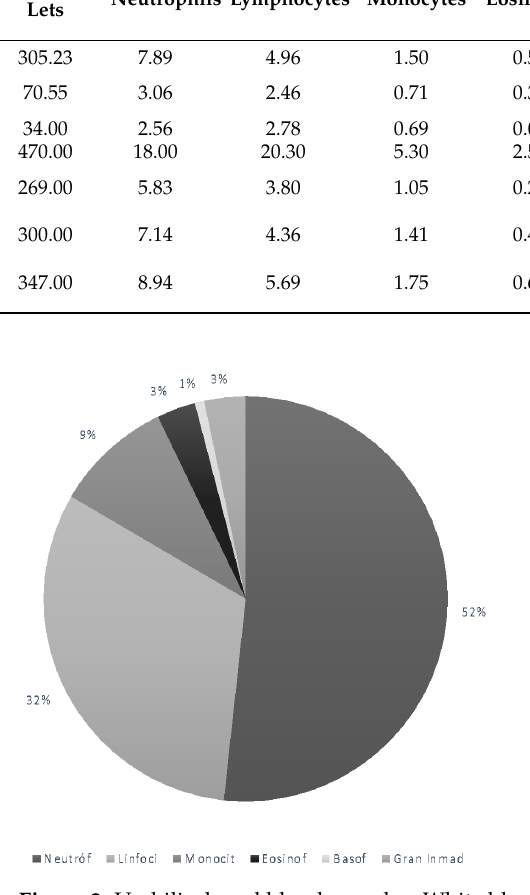
Figure 2. Umbilical cord blood samples. White blood cell subtypes. The mean values and corresponding standard deviations of IgG anti-SARS-CoV-2, IgM anti-SARS-CoV-2, IL6, IL1b, and IFN- γ in umbilical cord blood are shown in the Table 4. Table 4. Umbilical cord blood samples. Cytokines concentration. Ab IgM (U/mL)